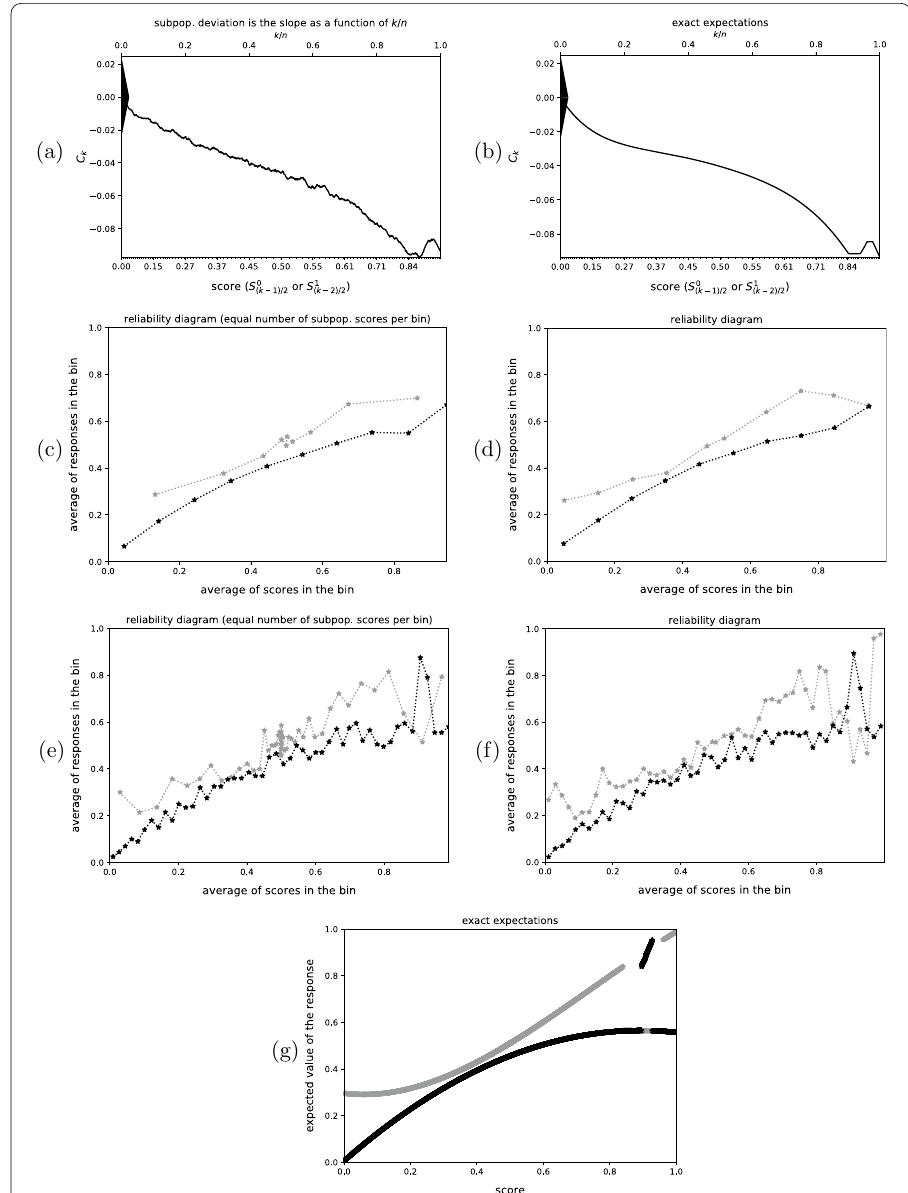
Fig. 1 n = 6451; Kuiper’s statistic is 0.09740 /σ = 7.823 , Kolmogorov’s and Smirnov’s is 0.09724 /σ = 7.810 ; the reliability diagrams with only 10 bins each ( c and d ) smooth out the jumps at high scores, and while the reliability diagrams with 50 bins each ( e and f ) give some indication of the jumps, the jumps still get smoothed over, while the bins for lower scores are too narrow to average away noise well. The cumulative graph ( a ) clearly displays the jumps, while remaining easily interpretable at lower scores. The statistics of Kuiper and of Kolmogorov and Smirnov are both several times greater than σ , so both reflect that the deviation displayed in the graphs is highly statistically